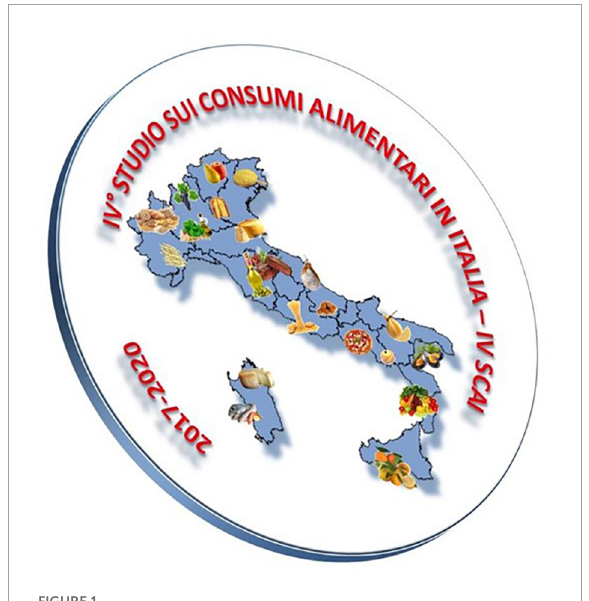
FIGURE1 IV Study on food consumption in Italy (IV